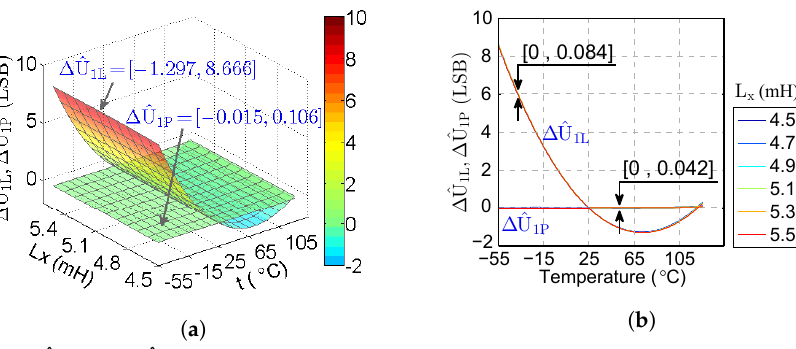
Figure 10. ∆ ˆU 1L and ∆ ˆU 1P with different L x displayed by: ( a ) 3D map (the estimated deviation ∆ ˆU 1P of our method is much less than the deviation ∆ ˆU 1L by LUT, especially at a low temperature); ( b ) 2D map (at each temperature point, the maximum of ∆ ˆU 1P is less than ∆ ˆU 1L with different L x ). Table 4. Comparison of statistical values ∆ ˆU 1L and ∆ ˆU 1P (the computed ˆU 1P by our method are closer to the theoretical U 1 than ˆU 1L by the LUT